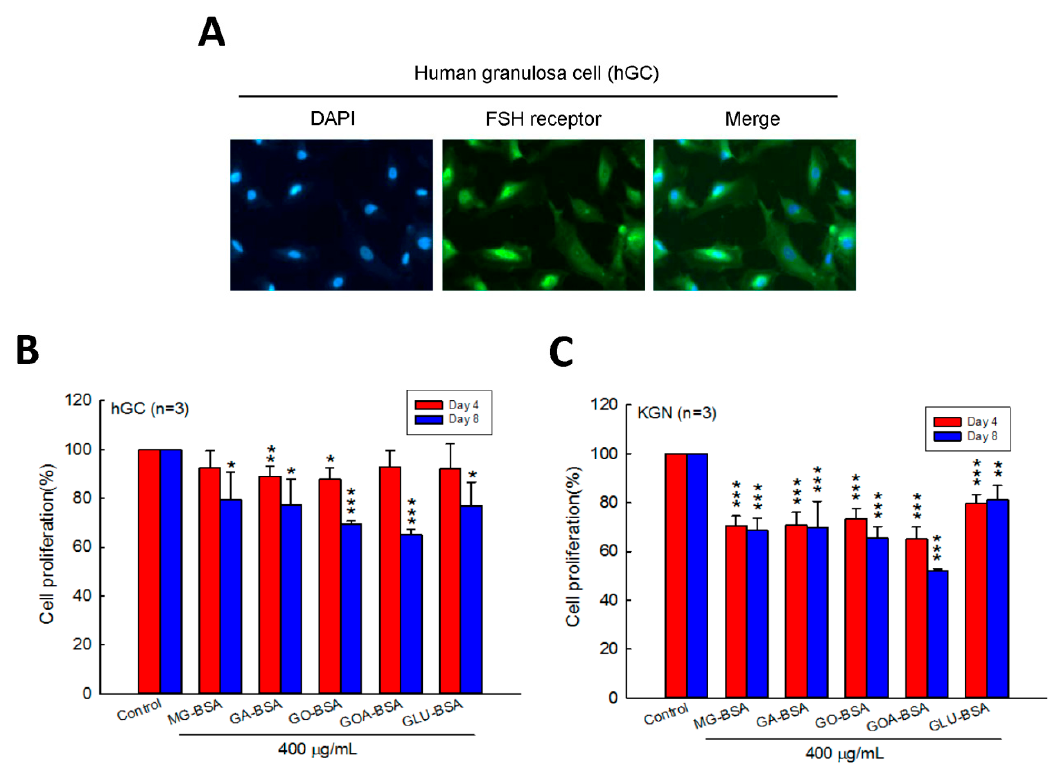
Figure 1. Effects of AGEs on the cell proliferation of human granulosa cells (hGC) and human granulosa-like (KGN) tumor cells. ( A ) Fluorescence microscopy analysis of the expressions of the FSH receptor (green) in human ovarian granulosa cells. DAPI (blue) was used to counterstain the nuclei. Overlay is presented. Treatment of both ( B ) hGC (5 × 10 3 cells per well) and ( C ) KGN (5 × 10 3 cells per well) cells with BSA (400 µ g / mL) as a control or five di ff erent AGEs for four and eight days. The cell proliferation rate was analyzed using the MTT assay. Data are shown as the mean ± SD ( n = 3). * p < 0.05, ** p < 0.01, *** p < 0.001 compared with the control group. MG-BSA, methylglyoxal- bovine serum albumin; GA-BSA, glyceraldehyde-bovine serum albumin; GO-BSA, glyoxal-bovine serum albumin; GOA-BSA, glycolaldehyde-bovine serum albumin; GLU-BSA, glucose-bovine serum albumin.